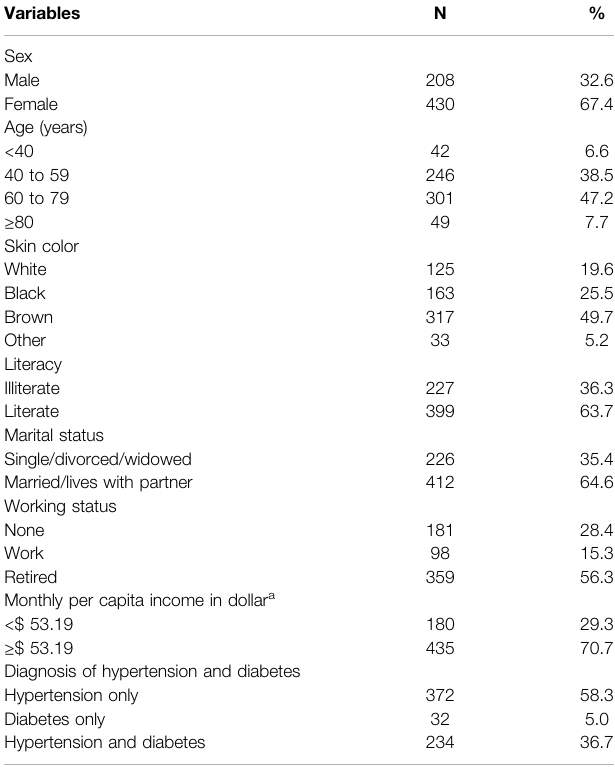
TABLE 1 | Sociodemographic characteristics and presence of disease of the study population.